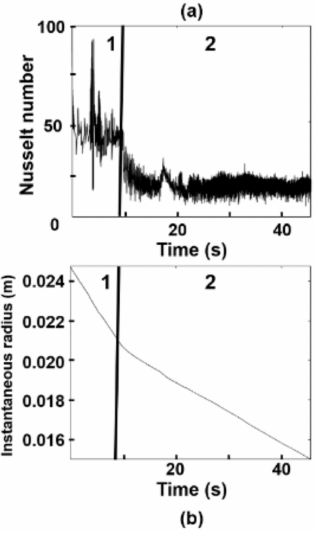
Figure 6. Instantaneous Nusselt number and its e ff ect on the melting rate of the shell. ( a ) Variations of Nusselt number with time when the particle falls in point E1. ( b ) Decrease of the shell thickness with time when the particle falls in point E1. Steel superheat is 15